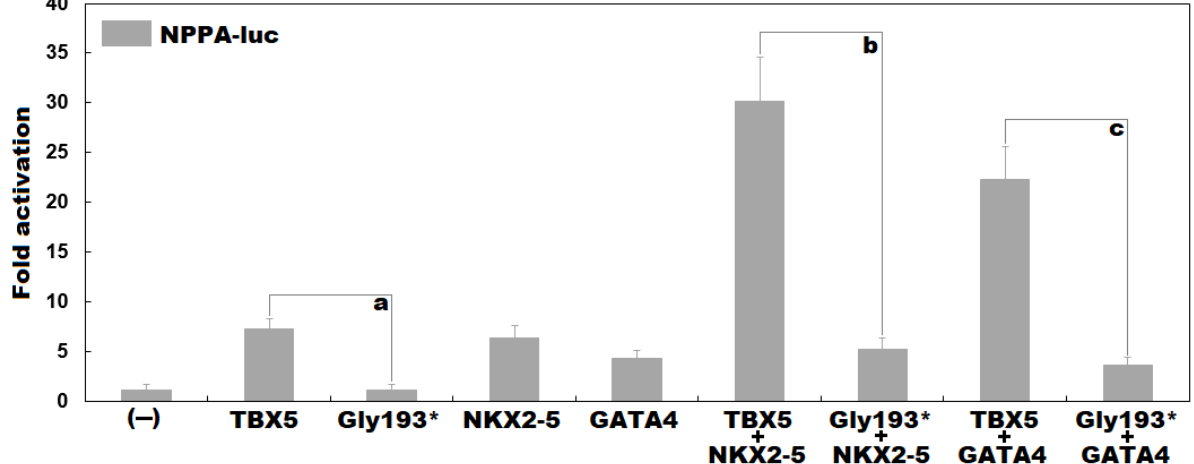
Figure 3 – Disrupted synergistic transactivation between mutant TBX5 and NKX2-5 as well as GATA4. The synergistic transactivation of the promoter of natriuretic peptide precursor A in cultured cells by TBX5 and NKX2-5 as well as GATA4 was ablated by the Gly193* mutation. Transfection experiments for each plasmid were done in triplicates, with means and standard deviations shown. Here the symbols a, b and c all indicate p <0.001, in comparison with their wild-type